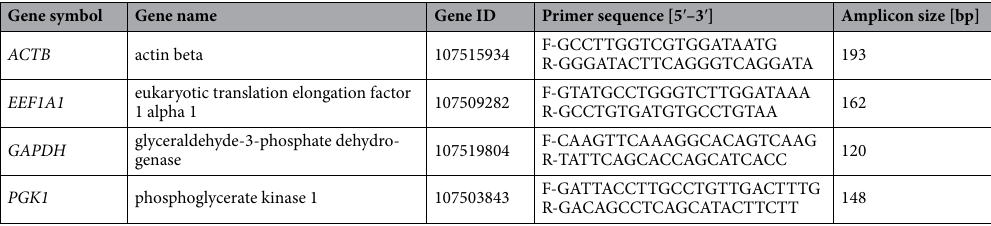
Selection of reference gene candidates and design of primer pairs. Reference gene candidates